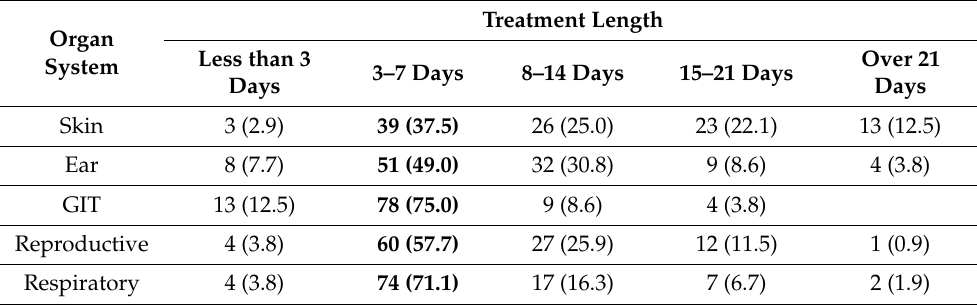
Table 3. Frequency and percentage of responses of the duration of treatment (columns) for different organ systems (rows). The values parentheses are the